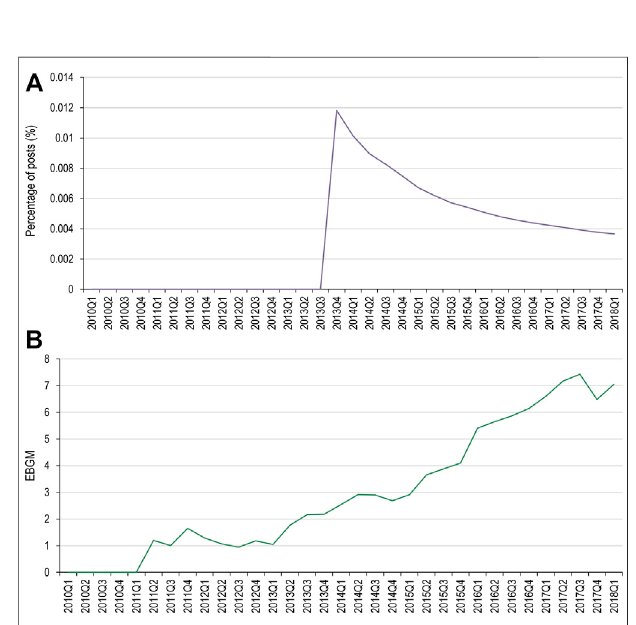
FIGURE 4 | Percentage of social media posts that mention denosumab and thoracic vertebral fracture as an adverse event (A) and EBGM scores for denosumab and thoracic vertebral fracture from FAERS data (B) FAERS, Food and Drug Administration Adverse Event Reporting System; Q, quarter; EBGM, empirical Bayes geometric